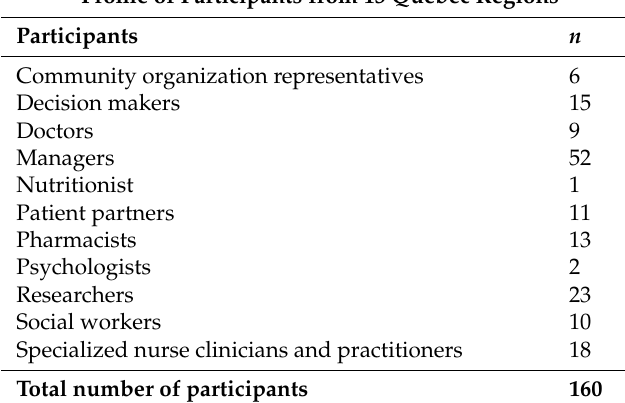
Table 1. Profile of